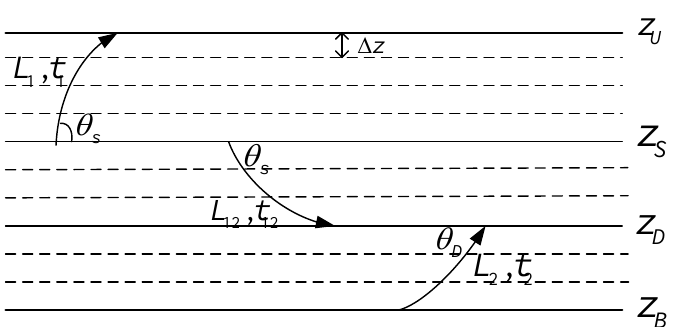
Figure 5. Specific forms of